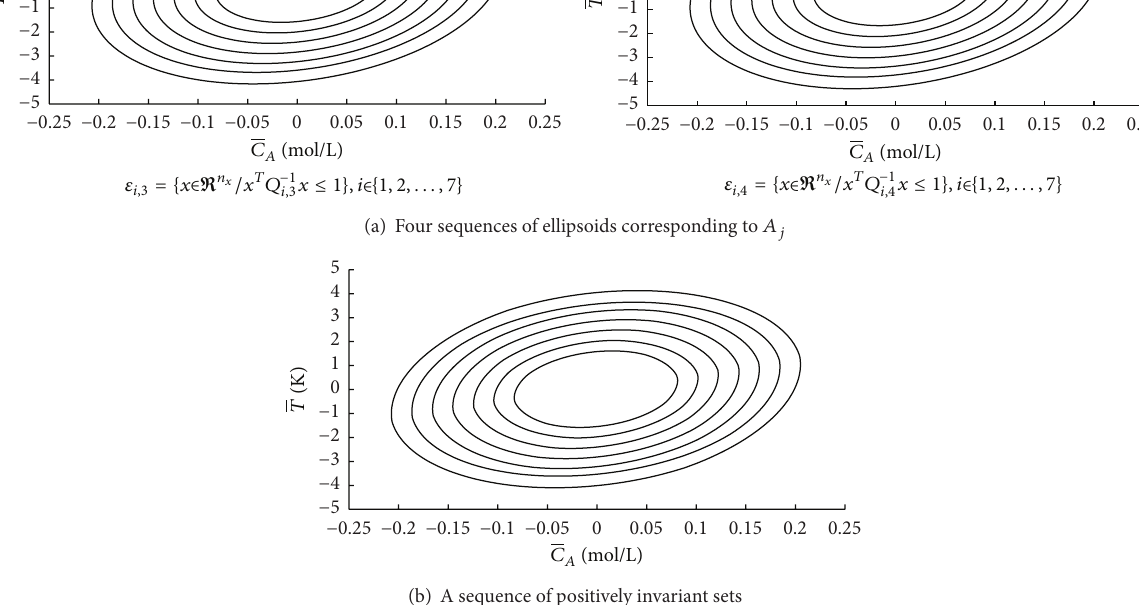
Figure 1: The ellipsoids computed offline in Example 1 (a) four sequences of ellipsoids corresponding to 𝐴 𝑗 (b) a sequence of positively invariant